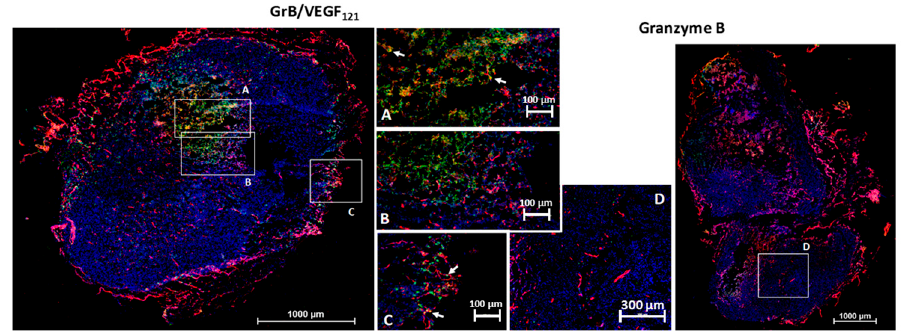
Figure 6. GrB/VEGF 121 localizes into the tumor and tumor perivascular space. Sections were stained with immunofluorescence reagents to detect murine blood vessels (CD31, red), nuclei (Hoechst, blue) and Granzyme B (green). Co-localization of GrB into CD31 + tumor vessels appears yellow (representative areas indicated with white arrows). ( A – C ) Localization of GrB/VEGF 121 into the PC-3 (prostate) tumor and the tumor perivascular space, as determined by immunofluorescence detection. ( D ) Free Granzyme B was not detected in the tumor using the same detection